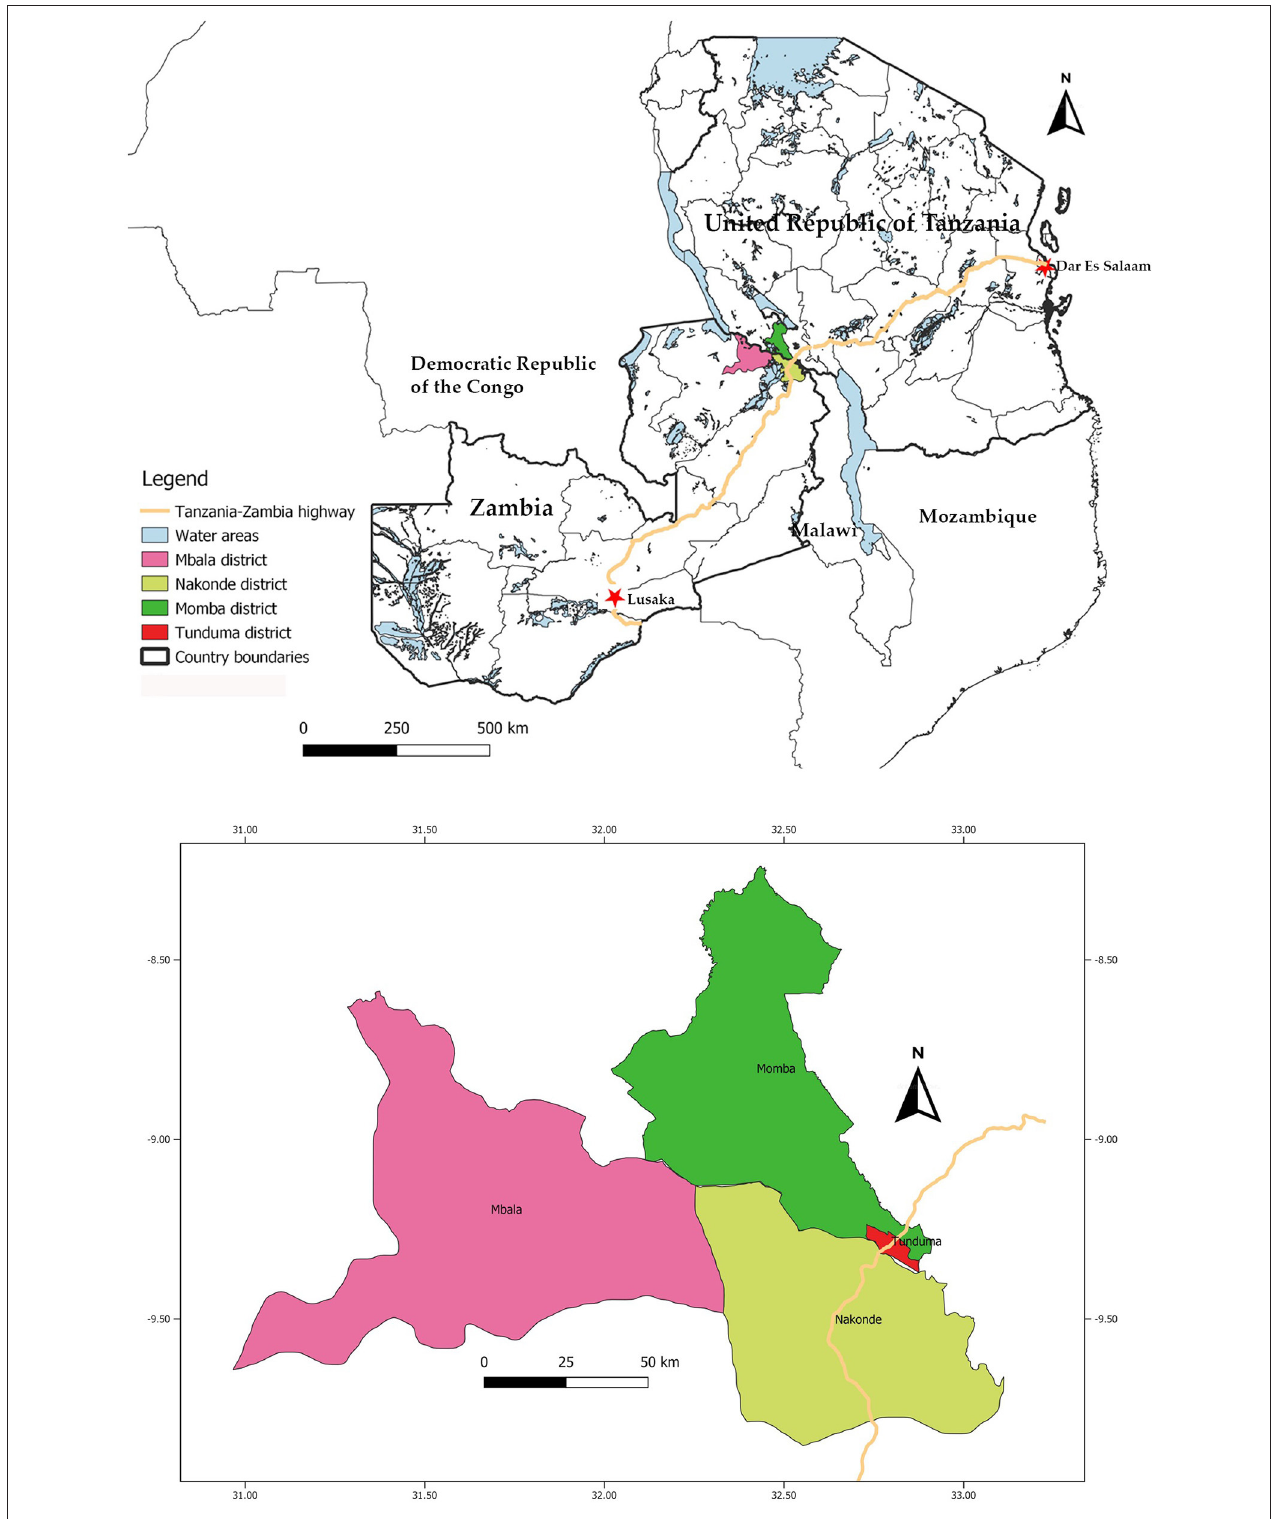
FIGURE 1 | The location of the visited districts in the Tanzania-Zambia border region, and of the Tanzania-Zambia highway. Map created in QGIS version 3.4.4 software (https://qgis.org).